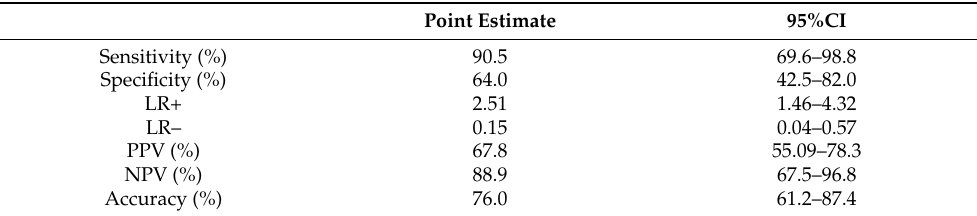
Table 3. Diagnostic test evaluation of the difference “(post-exercise)–(prior to exercise) tricuspid regurgitation velocity” > 0.5